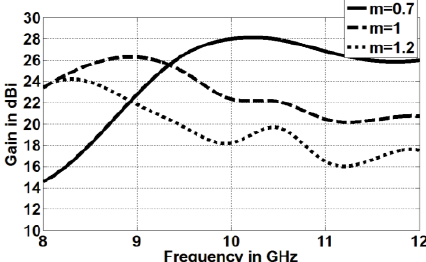
Figure 7: Calculated antenna gain for different values of correction coefficient m .